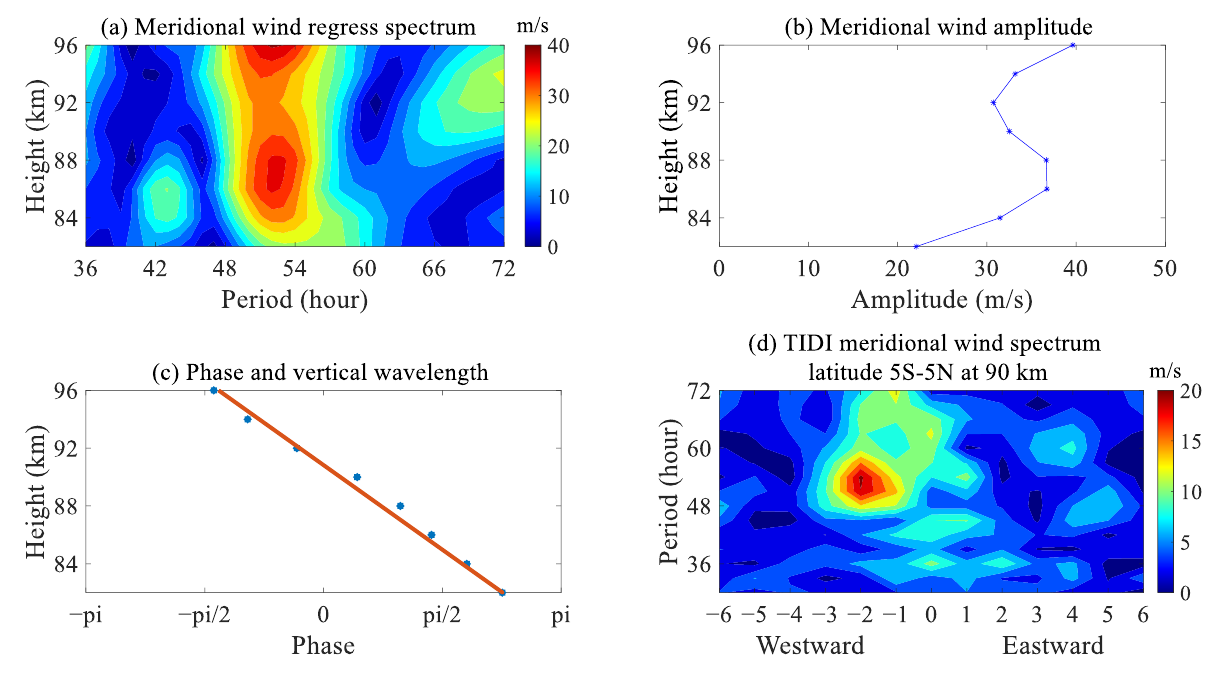
Figure 2. An example of QTDW events in meridional wind over KB from day 47 to day 61 in 2003. ( a ) The spectrum of meridional wind between 82 km and 96 km. ( b ) The amplitude of the QTDW. ( c ) The phase and the vertical wavelength of the QTDW. ( d ) The wavenumber spectrum of the TIDI meridional wind at 90 km.